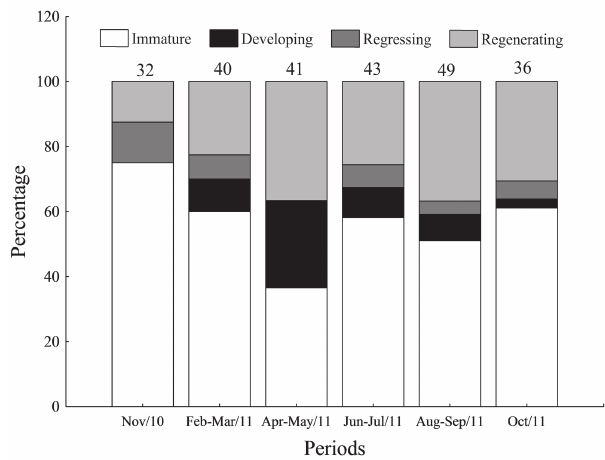
Fig. 4. Reproductive activity of Cichla piquiti , measured as the percentage of individuals in different reproductive phases within periods. Numbers above bars indicate sample size.